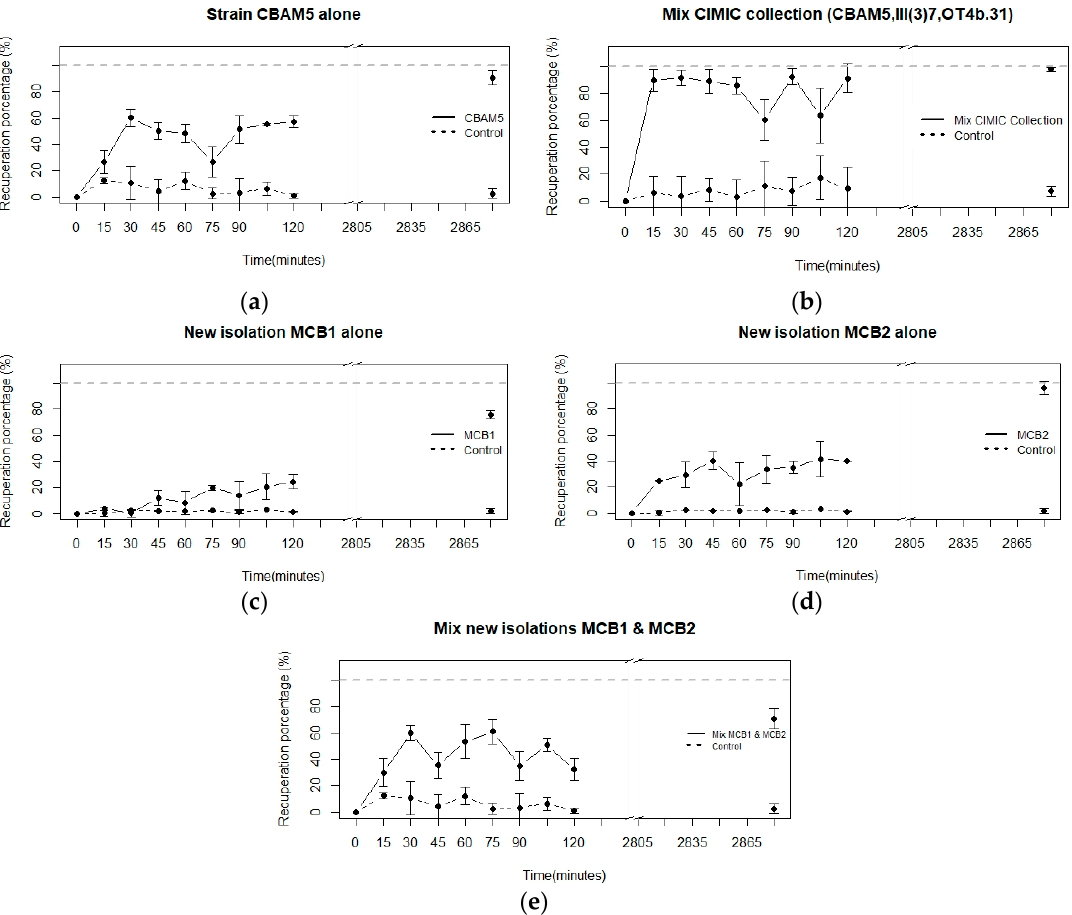
Figure 2. Bioassay in living cells with the L. sphaericus ( a ) CBAM5 as an individual strain, ( b ) CIMIC collection (CBAM5, OT4b.31, III(3)7) in a mix, ( c ) MCB1 and ( d ) MCB2 alone, and ( e ) mix with MCB1 and MCB2. The concentration of HAuCl 4 − evaluated was 60 µg/mL in minimum salt medium. Graphs show deviation standard for each time evaluated.